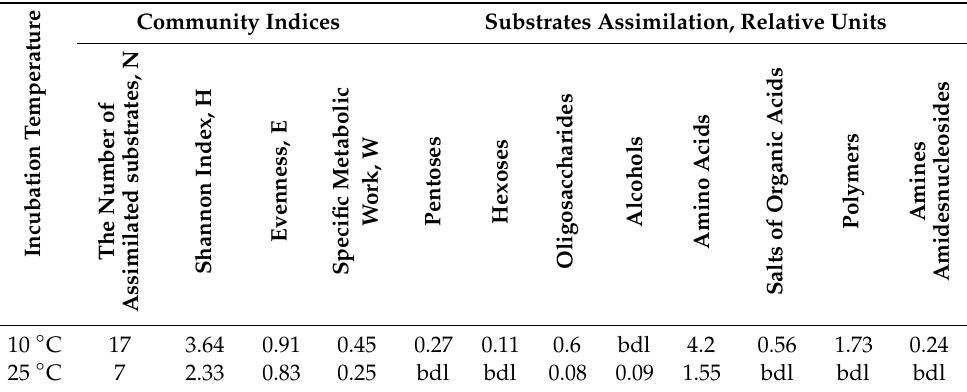
Table 3. Multisubstrate testing results.